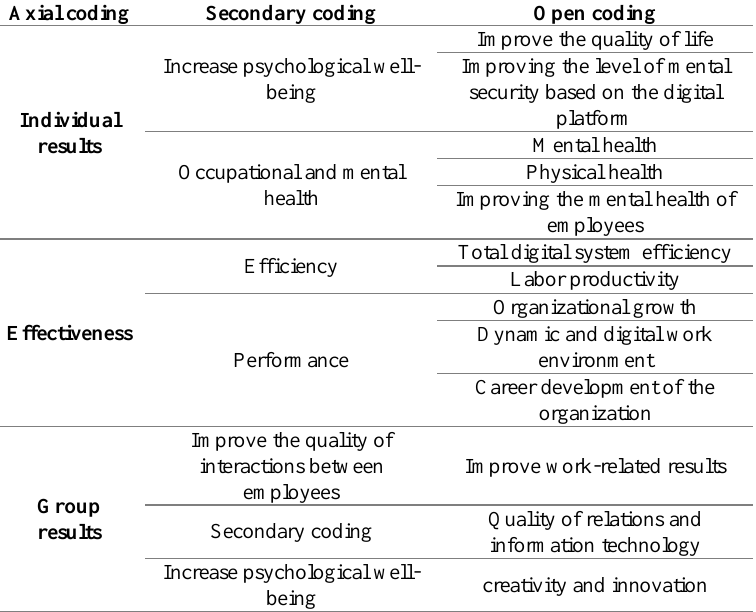
Table 6: Qualitative data coding (consequences) Axial